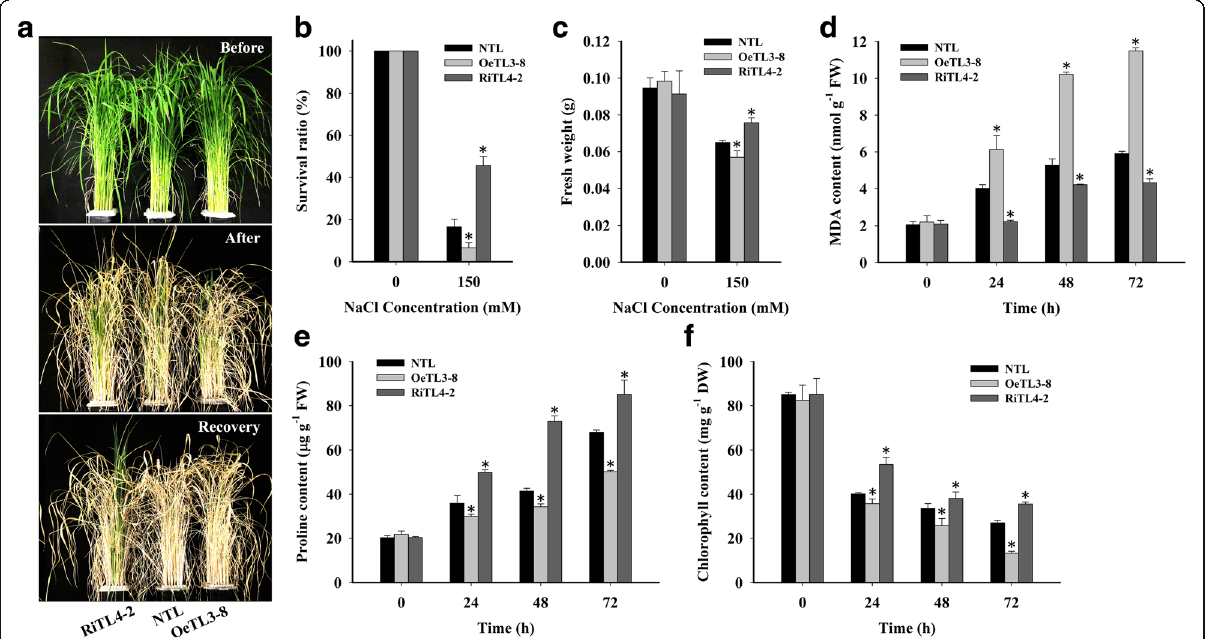
Fig. 3 OsRACK1A negatively regulates salt tolerance. a Comparison of the non-transgenic line (NTL), the OsRACK1A -overexpressing transgenic line (OeTL3 – 8), and the RNA-interfered transgenic line (RiTLs4 – 2) under 150 mM NaCl for 18 d (salt-stress recovery for 10 d). b Survival rate of plants after 150 mM NaCl treatment and recovery. c Fresh weight of plants after 150 mM NaCl treatment. d to f Contents of proline, MDA, and chlorophyll under 150 mM NaCl for 0, 24, 48 and 72 h. Sixty seedlings per genotype (twenty seedlings for each biological replicate) were used. Data shown are the means ± SE of three biological replicates. An asterisk indicates a significant difference ( P < 0.05) versus stressed